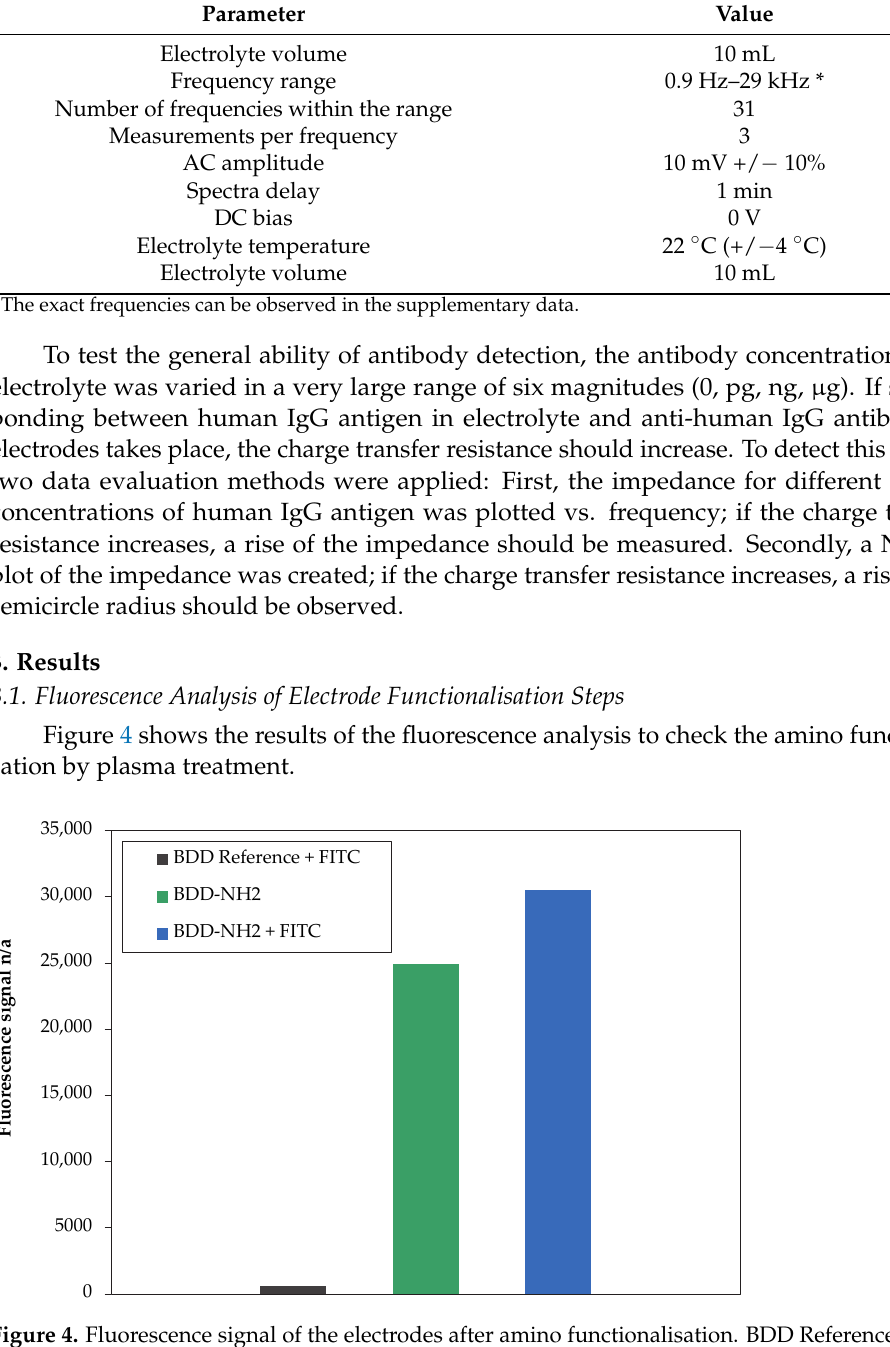
Figure 4. Fluorescence signal of the electrodes after amino functionalisation. BDD Reference + FITC: BDD-coated electrode with fluorescence marker. BDD-NH2: BDD-coated electrode with amino functionalisation. BDD-NH2 + FITC: BDD-coated electrode with amino functionalisation and with fluorescence marker.